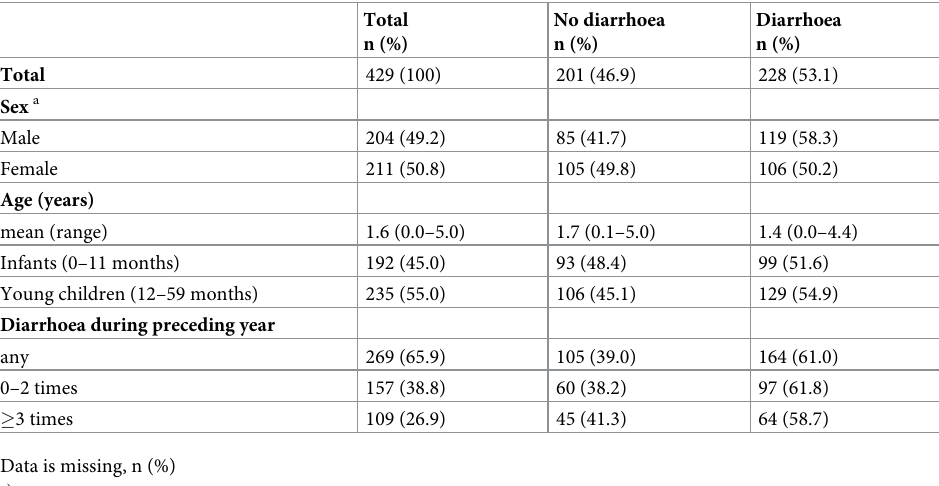
Table 1. Demographic data of the children